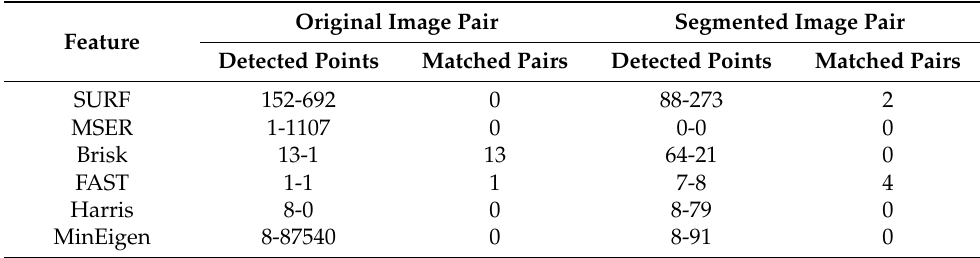
Table 1. Feature-based synthetic images registration